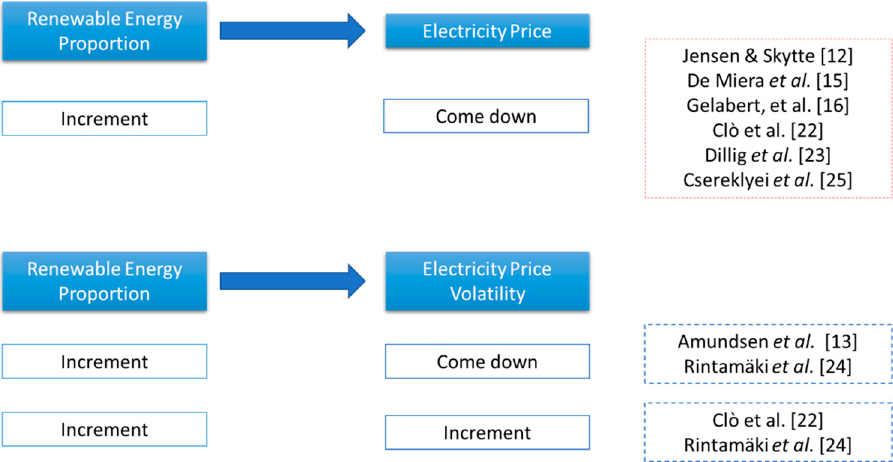
Figure 1. Summary of the studies and the cited empirical evidence.